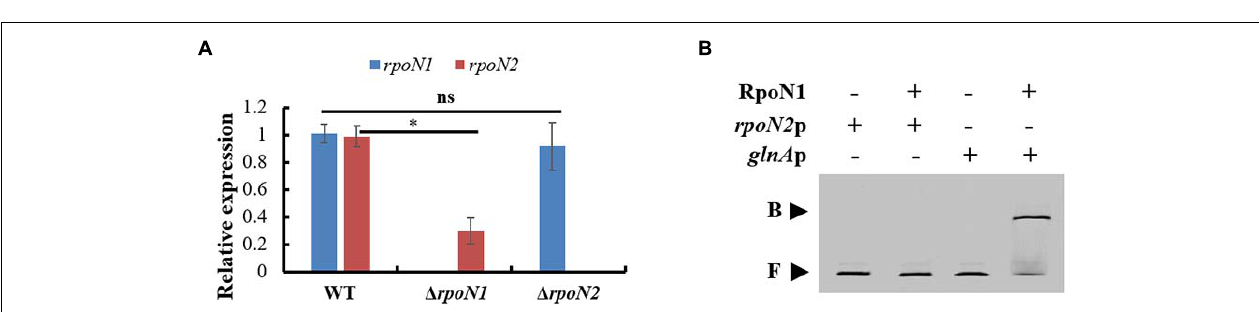
FIGURE 9 | RpoN1 indirectly regulates the expression of rpoN2 . (A) The expression patterns of rpoN1 and rpoN2 in (cid:49) rpoN1 and (cid:49) rpoN2 were investigated using qRT-PCR. (B) EMSA analysis to assess the interaction between RpoN1 and rpoN2 promoter. rpoN2 p, the promoter of rpoN2 ; glnA p, the promoter of glnA ; B, binding probe; F, free probe. In RNA-seq data, the glnA encoded glutamine synthetase expression was significantly decreased in (cid:49) rpoN1 (data not shown). Thus, glnA p was selected as a positive control. Asterisk and ns indicate significant and insignificant differences, respectively ( P -value < 0.05) (Student’s t test).